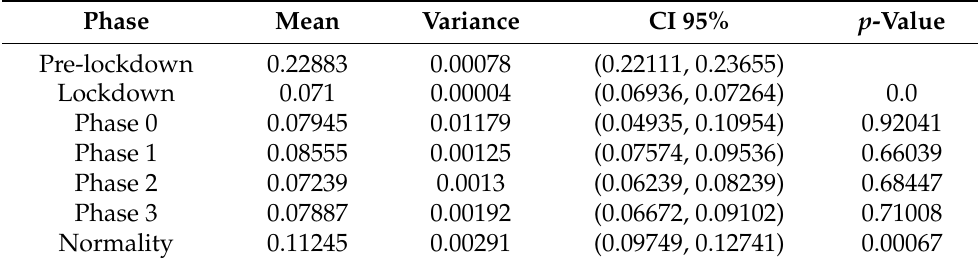
Table 2. Statistics for the Spanish Histogram (Non-delayed).